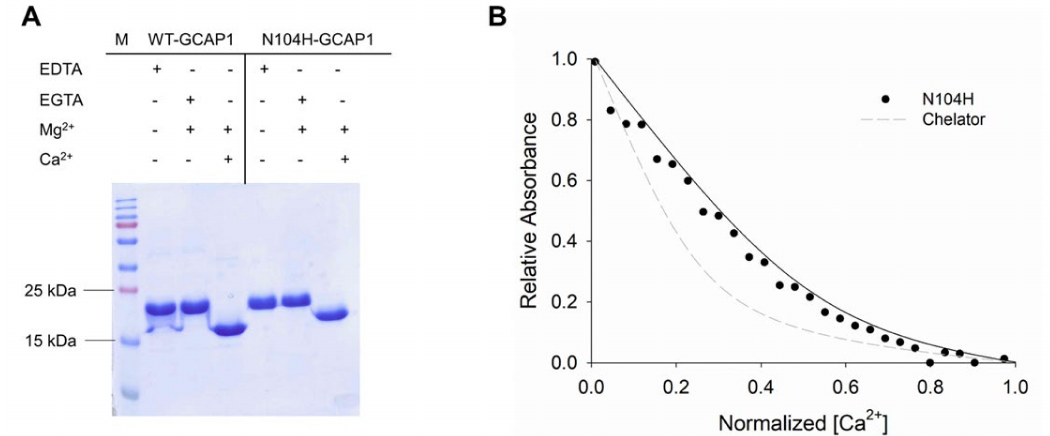
Figure 6. Ca 2+ -binding assays for N104H-GCAP1. ( A ) The 15% SDS-PAGE gel of 30 µ M of WT and N104H-GCAP1 in the presence of 2 mM EDTA, 1 mM EGTA + 1.1 mM Mg 2+ , 1 mM Mg 2+ and 1 mM Ca 2+ . ( B ) Example of a Ca 2+ -titration curve for N104H-GCAP1. The normalized absorption of 5,5 (cid:48) Br 2 -BAPTA in competition with N104H-GCAP1 upon Ca 2+ -titration in the presence of 1 mM Mg 2+ is shown as black circles, together with data fitting to a three-Ca 2+ -binding site model using CaLigator [31] (black line), and the theoretical curve of the chelator in the absence of competition (grey dashed